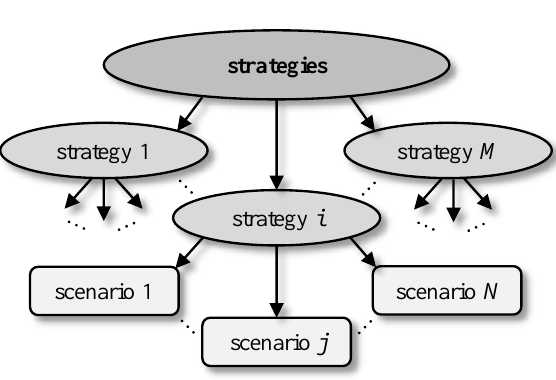
Fig. 4. Structure of the simulation